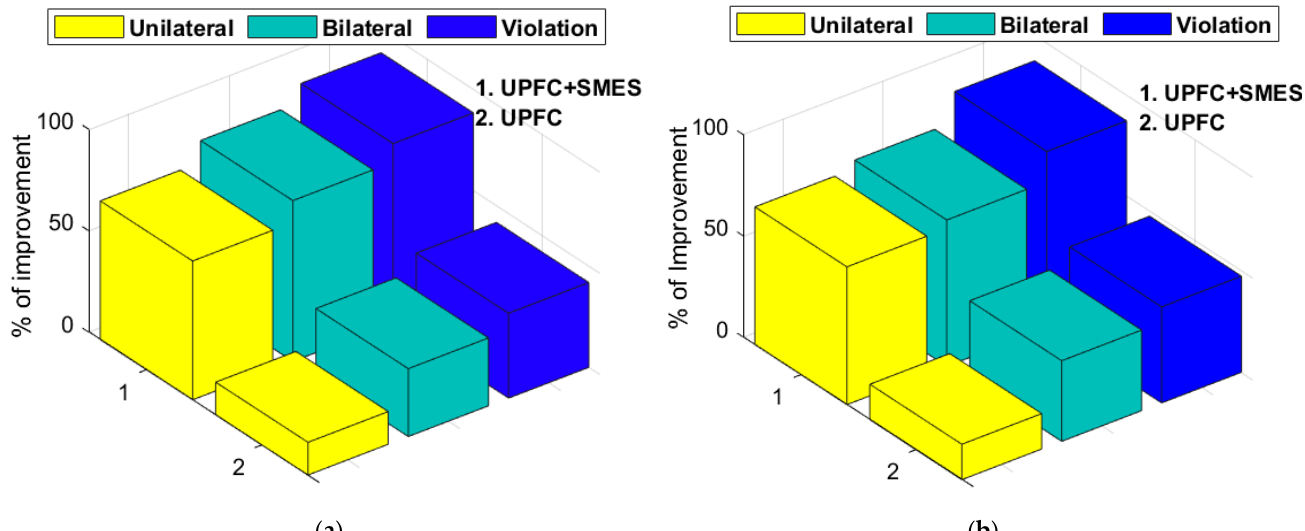
Figure 16. Comparison of the impact of ancillary device on deregulated power system operation in the case of three contracts with respect to the frequency deviation—percentage improvements relative to the case without ancillary: ( a ) frequency improvement in area-1; ( b ) frequency improvement in area-2.